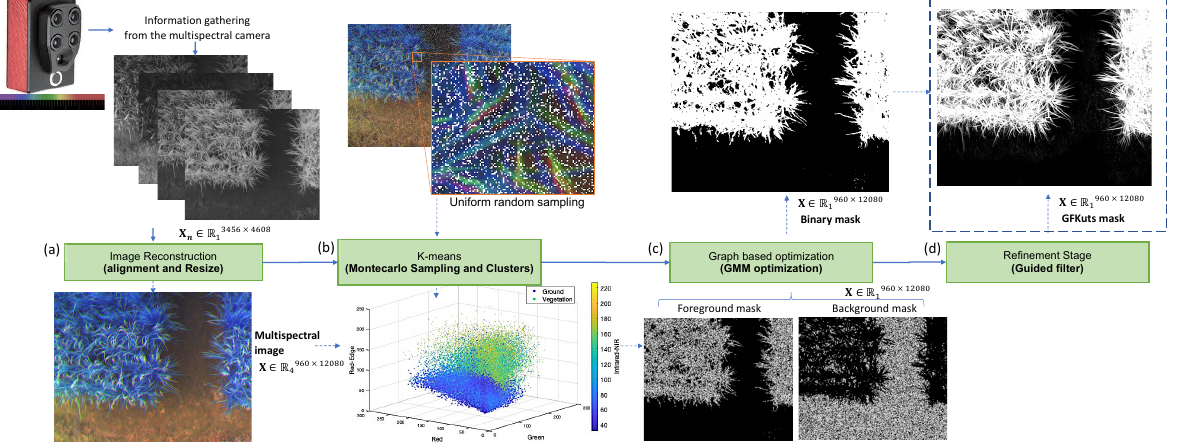
Figure 2. GFKuts approach. ( a ) Preprocessing stage, ( b ) binary classification approach, ( c ) GMM modeling & optimization, and ( d ) filter